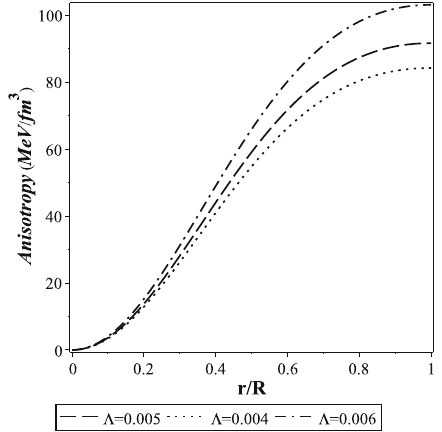
Fig. 4 Behavior of the anisotropic stress Δ as a function of the frac- tional radial distance for the strange star candidate LMC X − 4 is shown